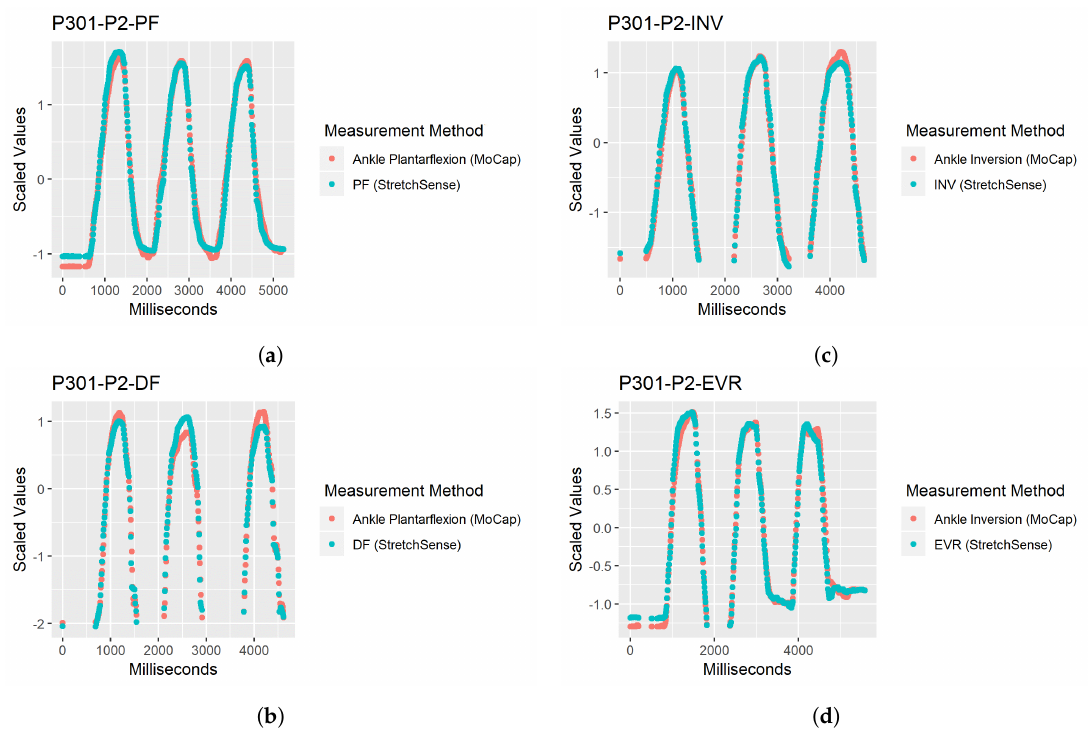
Figure 7. Examples of Preprocessed data: ( a ) preprocessed data for plantar flexion (PF) movement at POC 2; ( b ) preprocessed data for dorsiflexion (DF) movement at POC 2; ( c ) preprocessed data for inversion (INV) movement at POC 2; and ( d ) preprocessed data for eversion (EVR) movement at POC